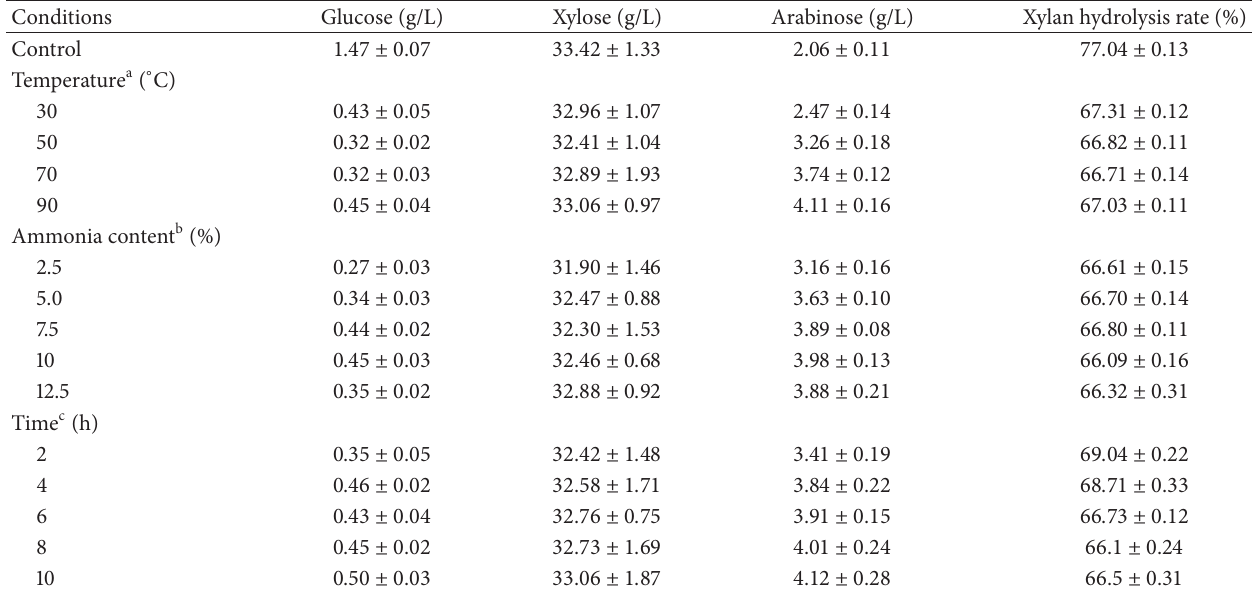
Table 1: Influence of SAA conditions on recovery of sugars and xylan hydrolysis.